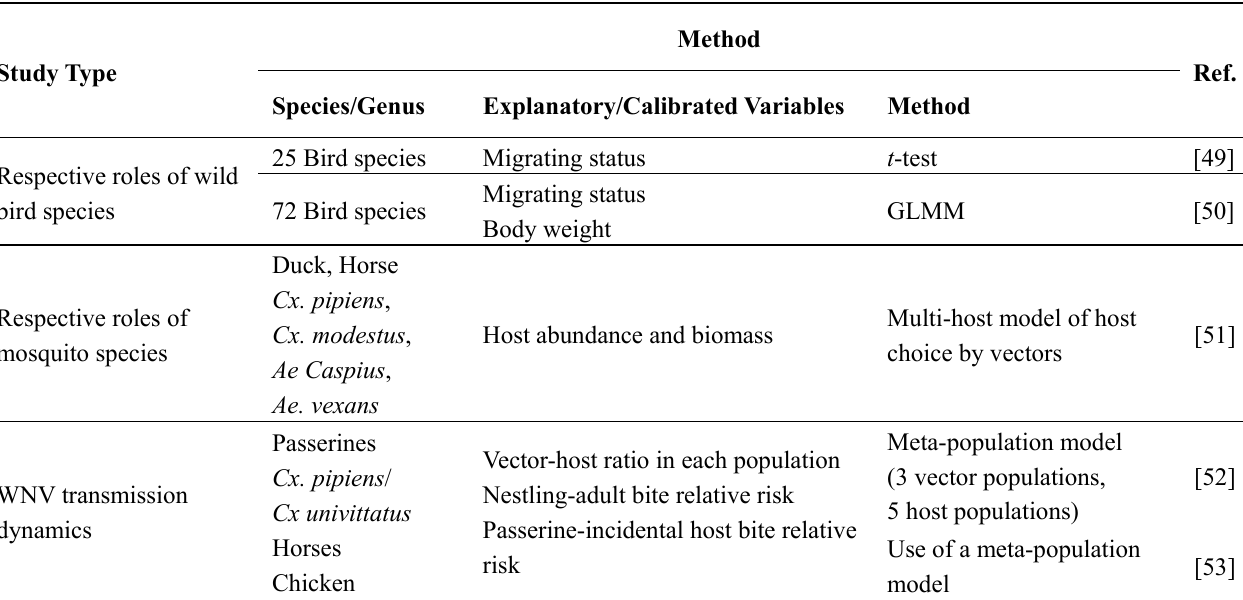
Table 3. List of articles addressing the respective roles of vector species and of wild bird species in WNV transmission, and WNV transmission dynamics. Ref. stands for